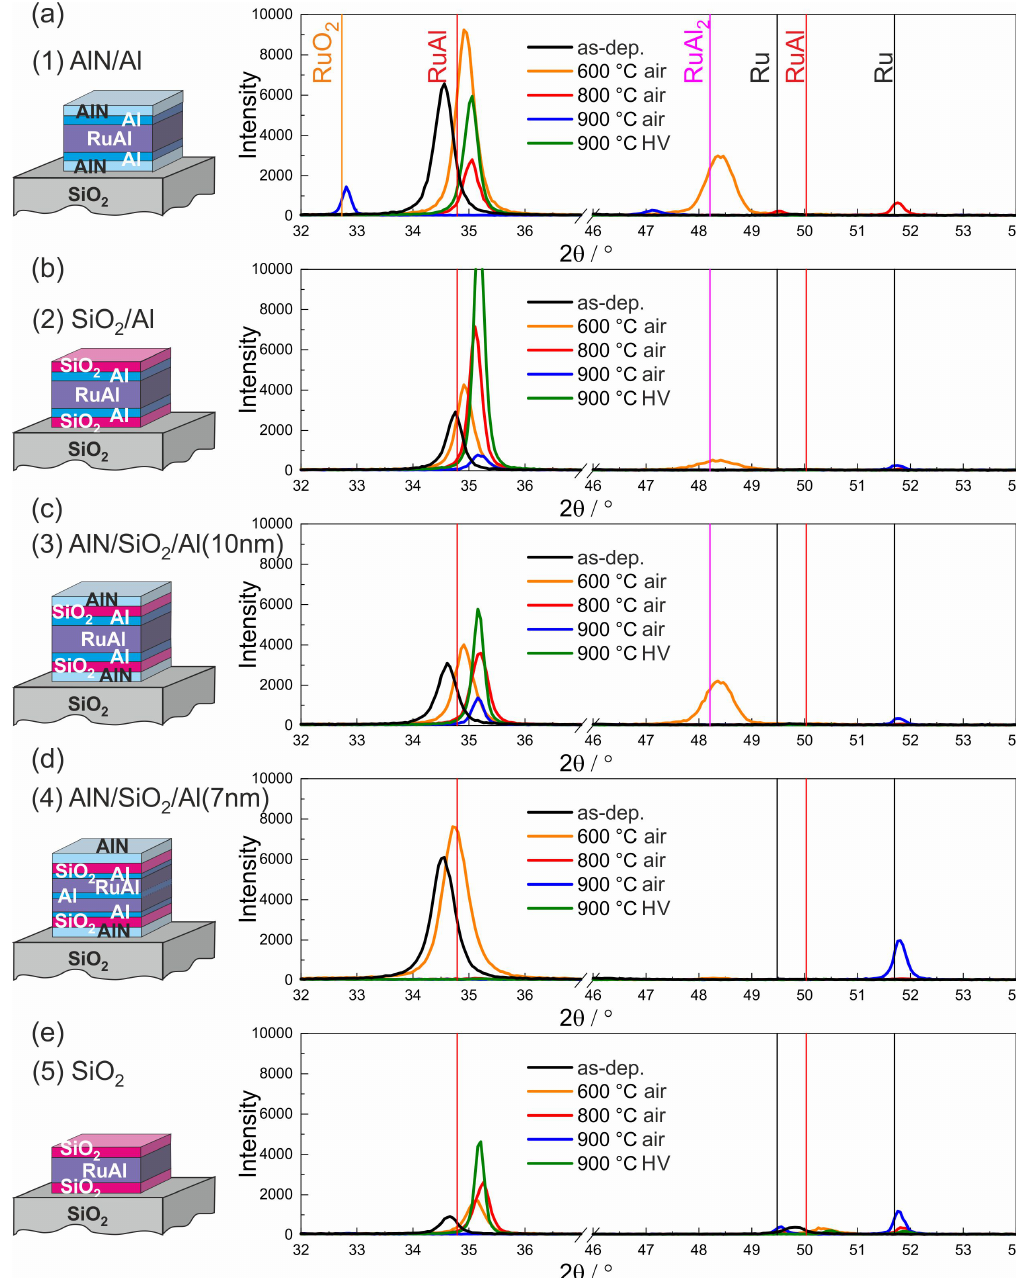
Figure 6. Results of the XRD measurements (Bragg–Brentano, Co-K α ) for the samples with the different cover and barrier layers on SiO 2 /Si substrates: ( a ) (1)-AlN/Al, ( b ) (2)-SiO 2 /Al, ( c ) (3)-AlN/SiO 2 /Al(10 nm), ( d ) (4)-AlN/SiO 2 /Al(7 nm), and ( e ) (5)-SiO 2